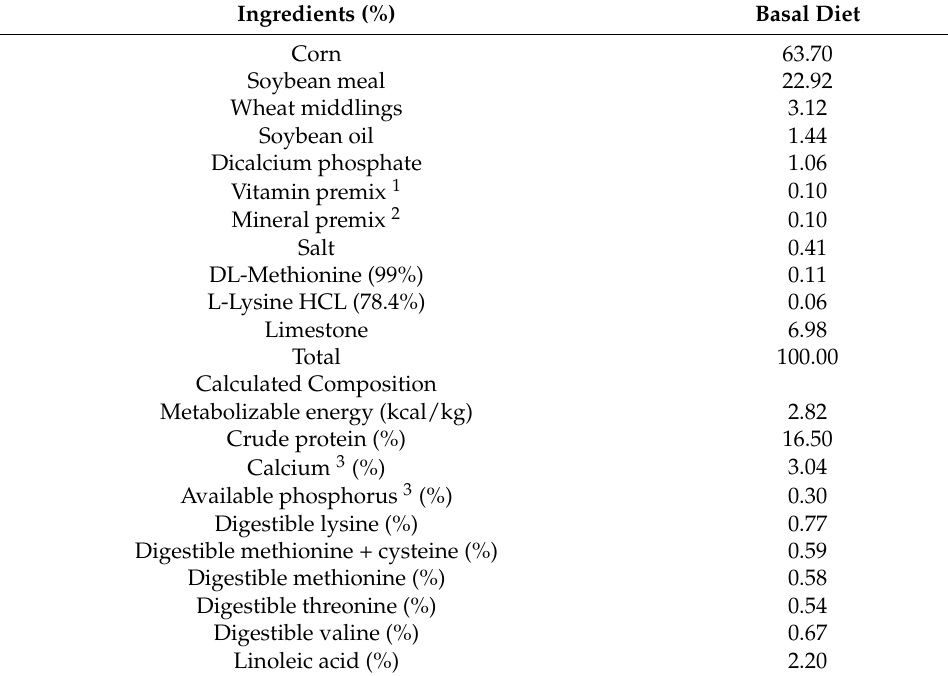
Table 2. Ingredients and calculated composition in an experimental diet for broiler breeders fed superdoses of